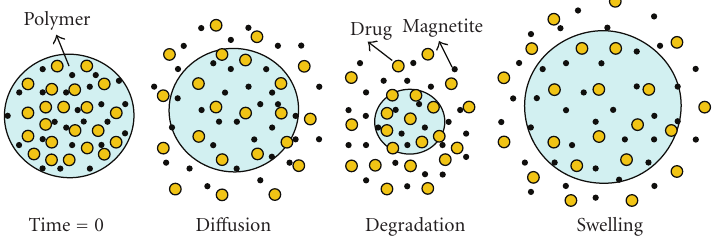
Figure 1: Schematic illustrations of di ff usion, degradation, and swelling release mechanisms of drug-carrying magnetic PLGA spheres.